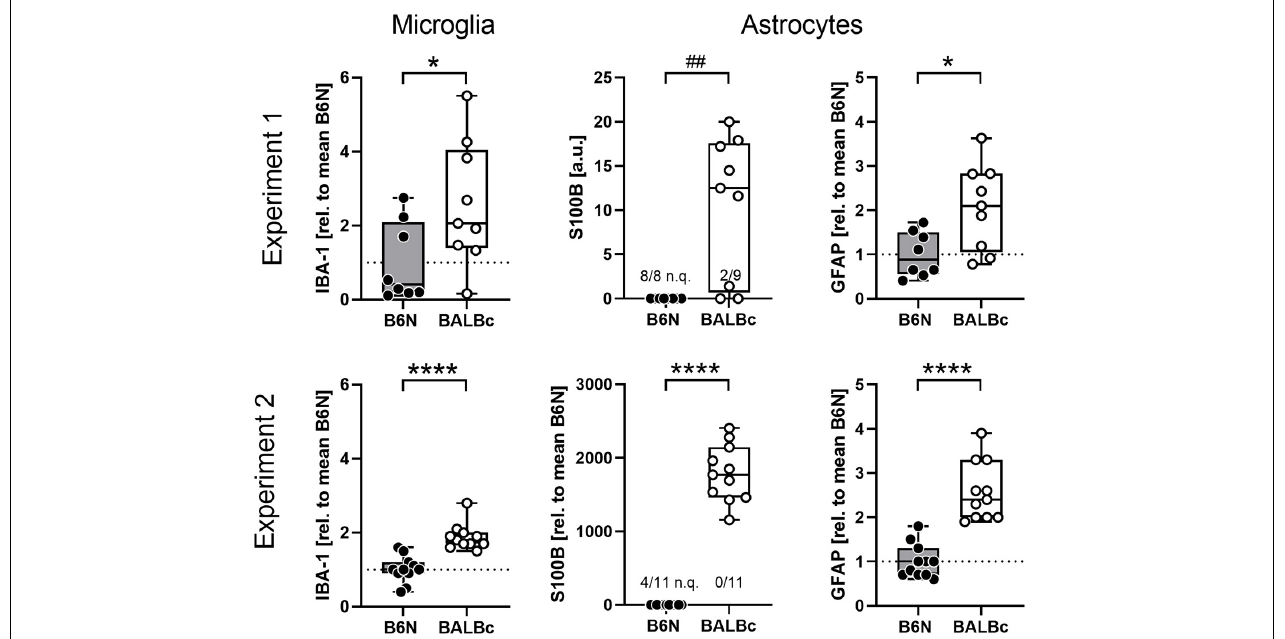
FIGURE 3 | BALBc mice showed increased levels of glial markers in the dorsal hippocampus. Brain specimens were collected from the dorsal hippocampus of B6N and BALBc mice at the end of Experiments 1 and 2 corresponding to an age of 3 vs. 12 months. Protein simple measurements revealed elevated levels of microglia (IBA-1) and astrocytic (S100B, GFAP) markers in BALBc compared to B6N. If possible, data were normalized to the mean of B6N. In some cases, the signal was too weak for quantification (n.q.) which precluded normalization. * p < 0.05, **** p < 0.0001 ( t -test), ## p < 0.01 (Mann–Whitney U